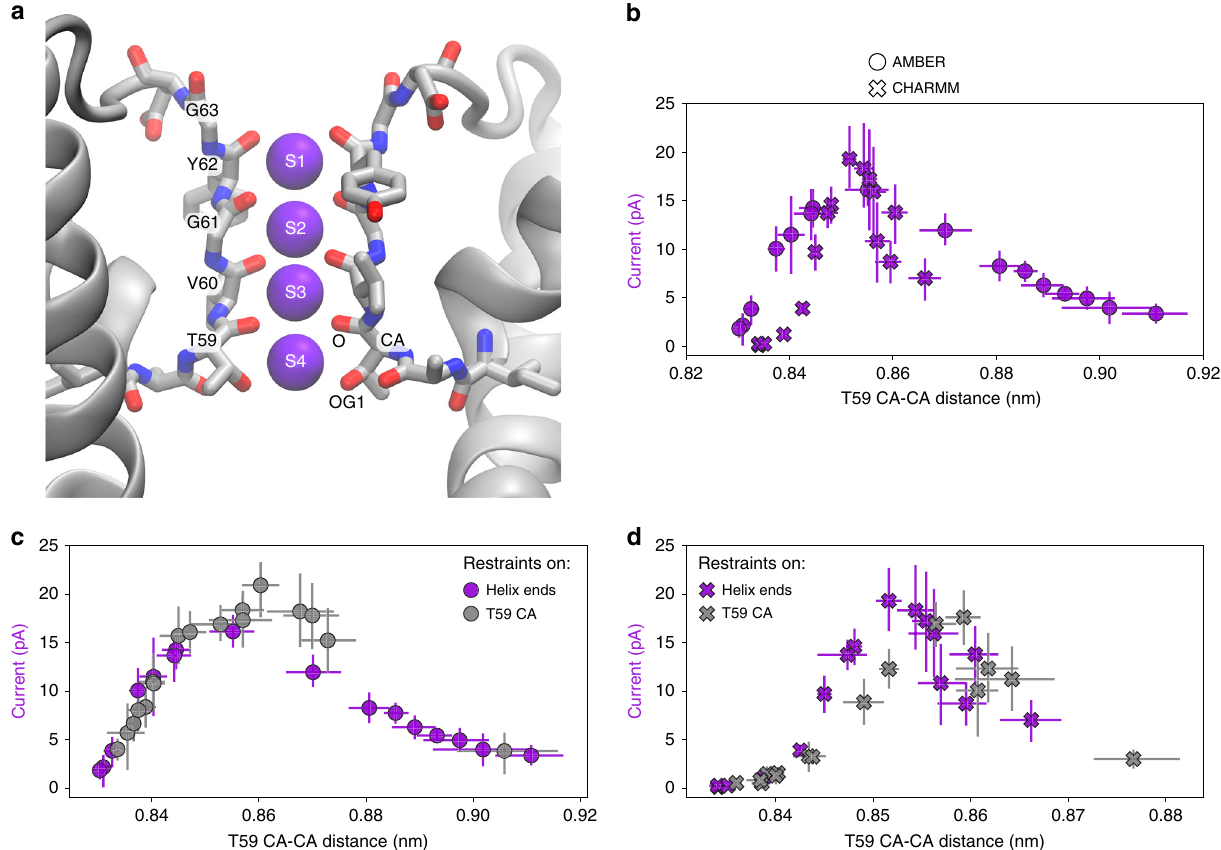
Fig. 2 Current regulation in MthK at its SF. a Structure of the MthK SF, formed by the signature sequence TVGYG, with SF residues shown in sticks and K + ions occupying ion binding sites S1 – S4 shown as purple spheres. Two diagonally opposite monomers are shown for clarity. b Outward K + current through MthK at 300 mV as a function of SF opening at T59 forming S4. c , d Comparison of current variations when distance restraints are applied to the ends of TM helices (purple marks, same as in b ) or directly to the T59 CA atoms (gray marks), for AMBER and CHARMM force fi elds, respectively. Error bars represent 95% con fi dence intervals. Source data are available as a Source Data fi